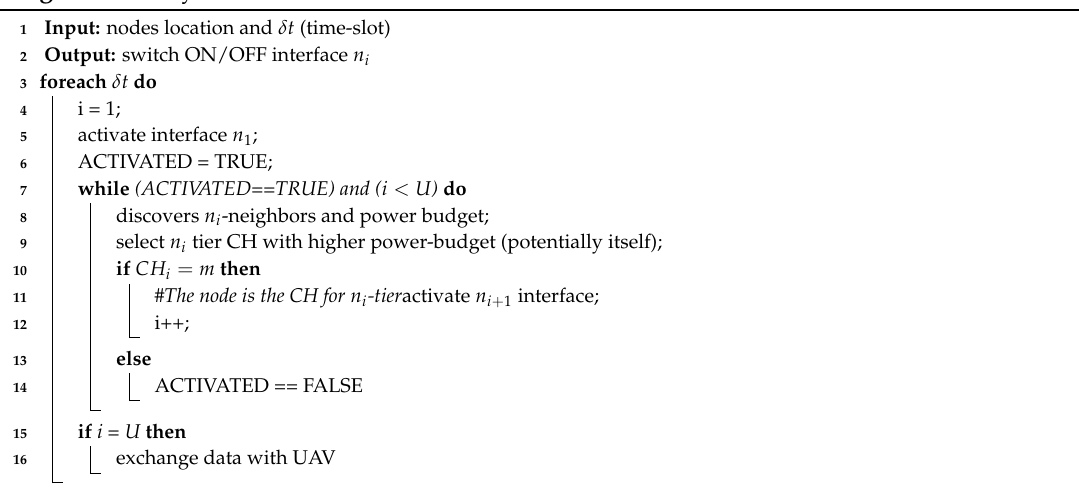
Algorithm 1: Dynamic CH selection run at each node m .